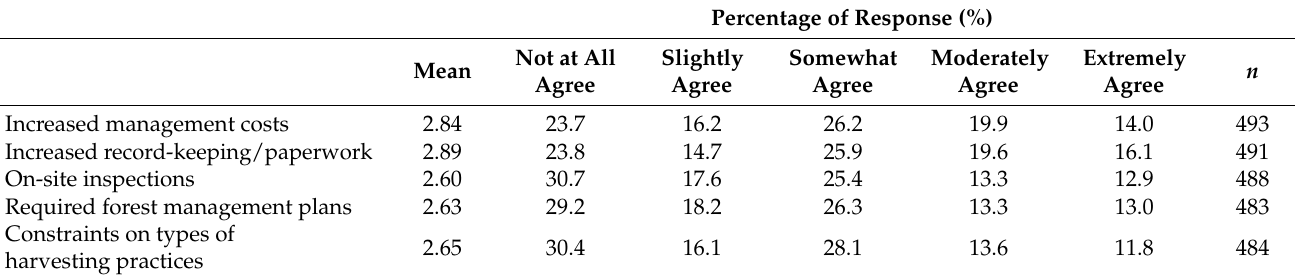
Table 3. Landowners’ agreement regarding perceived drawbacks associated with forest